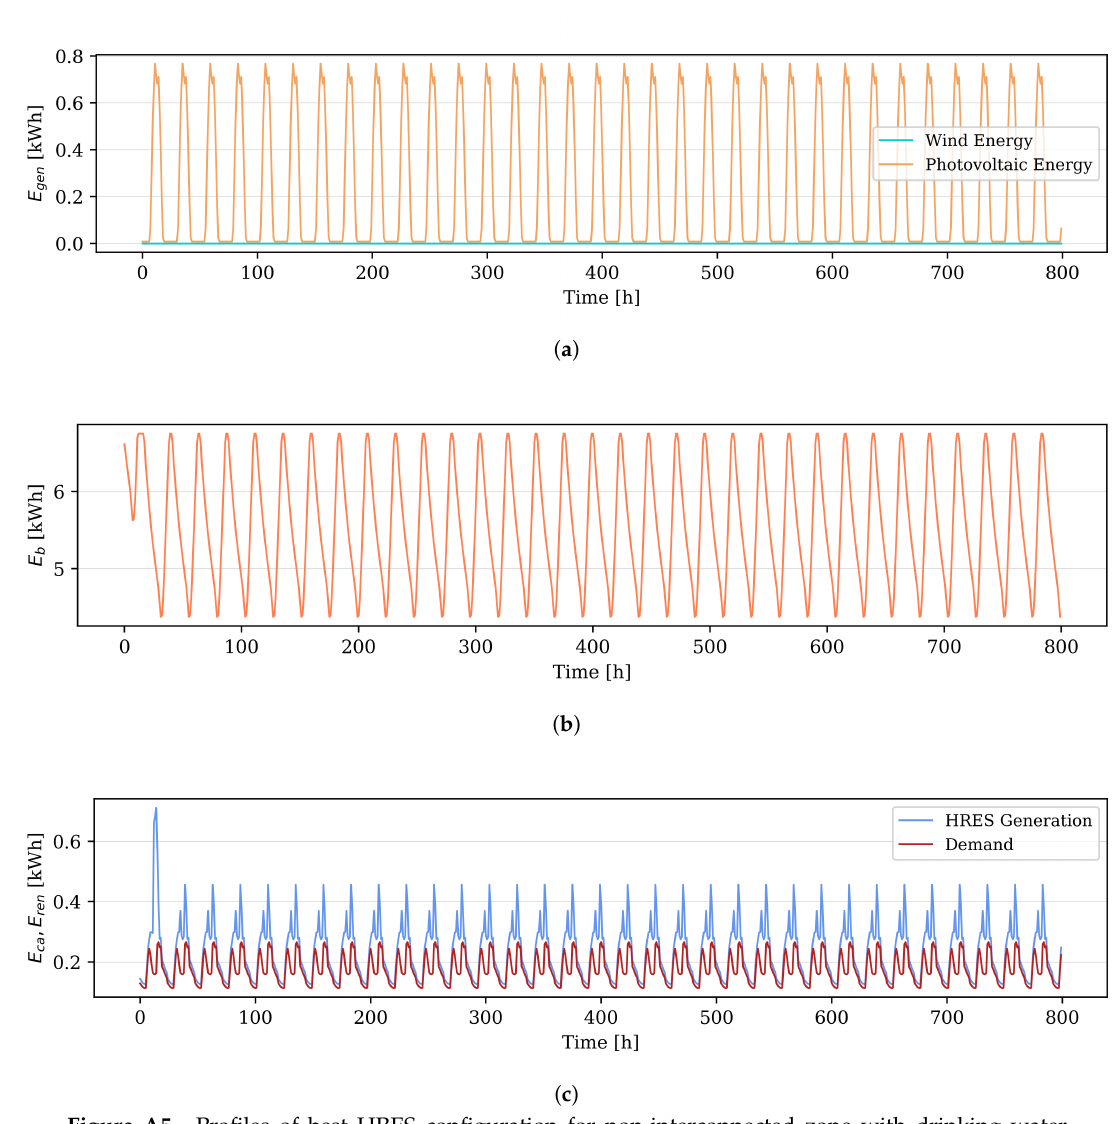
Figure A5. Profiles of best HRES configuration for non-interconnected zone with drinking water consumption (4.27 kW-h/day) obtained by multi-objective function with TAC , N pv ,1 = 6, N pv ,3 = 1, N b = 5. ( a ) Total renewable energy generation. ( b ) Storage system state. ( c ) HRES generation vs.